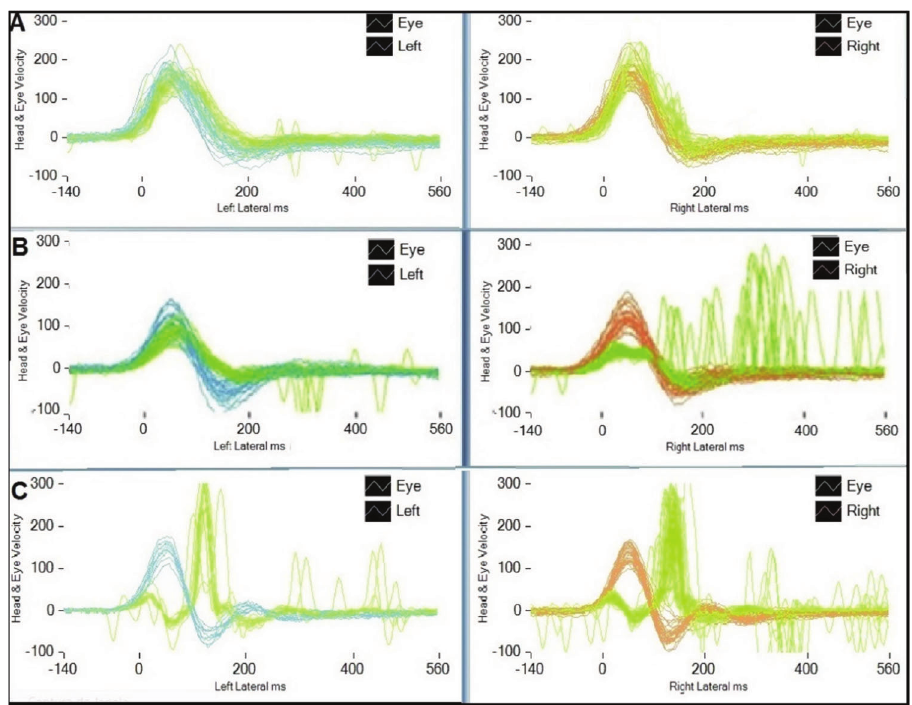
Figure 1 - vHIT chart: (A) normal test, (B) low gain and refixation overt saccades on the right side, (C) bilateral vestibular loss (ICS Impulse